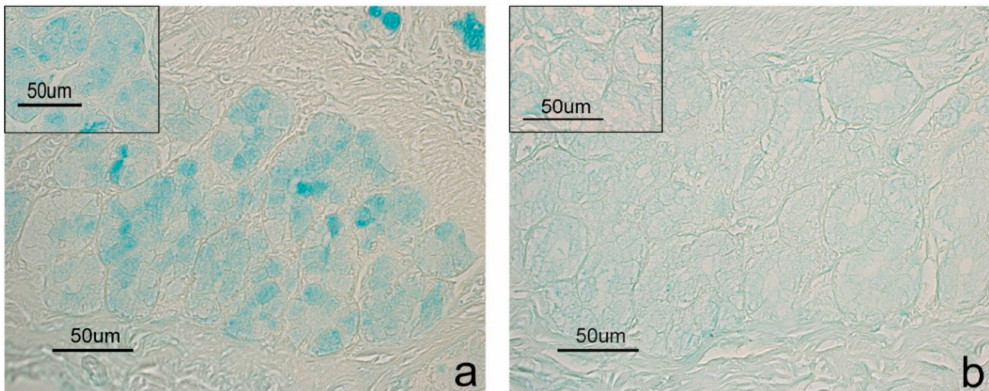
Figure 3. Duodenal glands from CTR samples. The sequential AB ( a ) and Sial-AB ( b ) histochemical treatments produce a decrease of reaction intensity. Insets in each image show the reactivity to the same histochemical treatments of EXP samples.